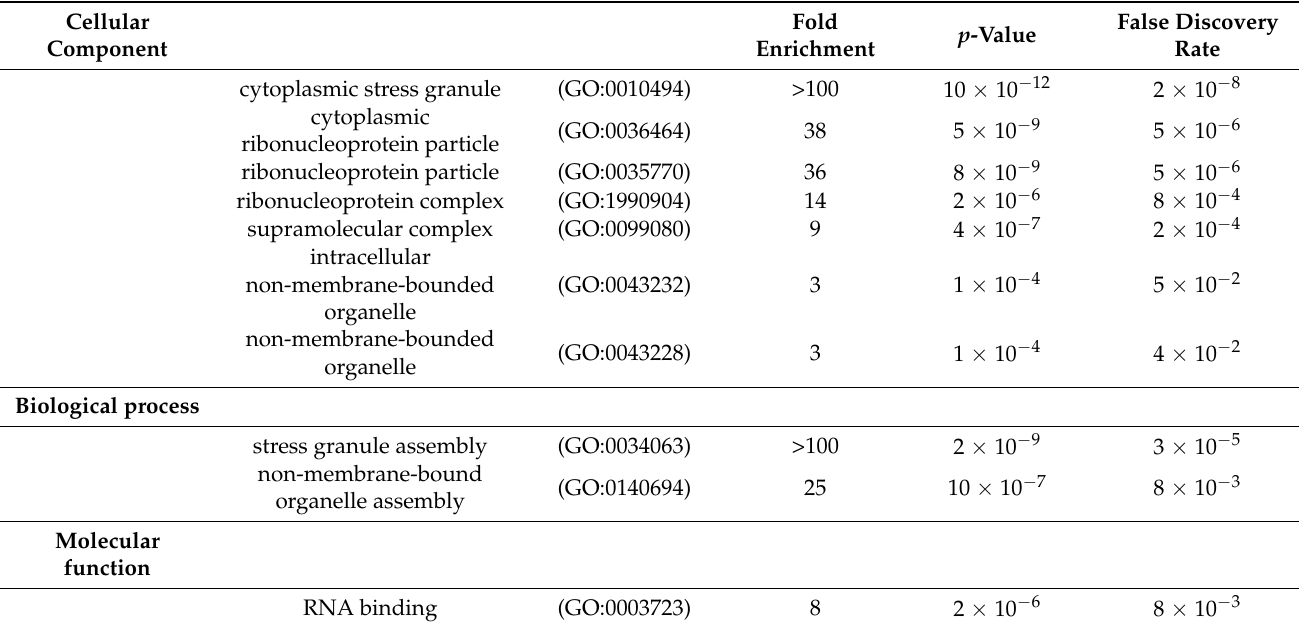
Table 2. Statistical overrepresentation among PTCHD1-specific interactors.